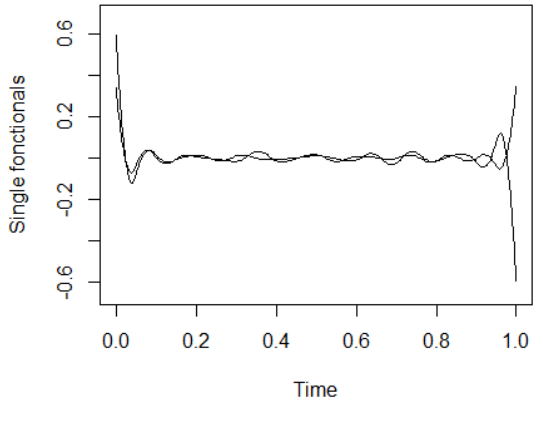
Figure 2: The curves θ i =1,2 (cid:0) t j (cid:1) , t j ∈ [0, 1]